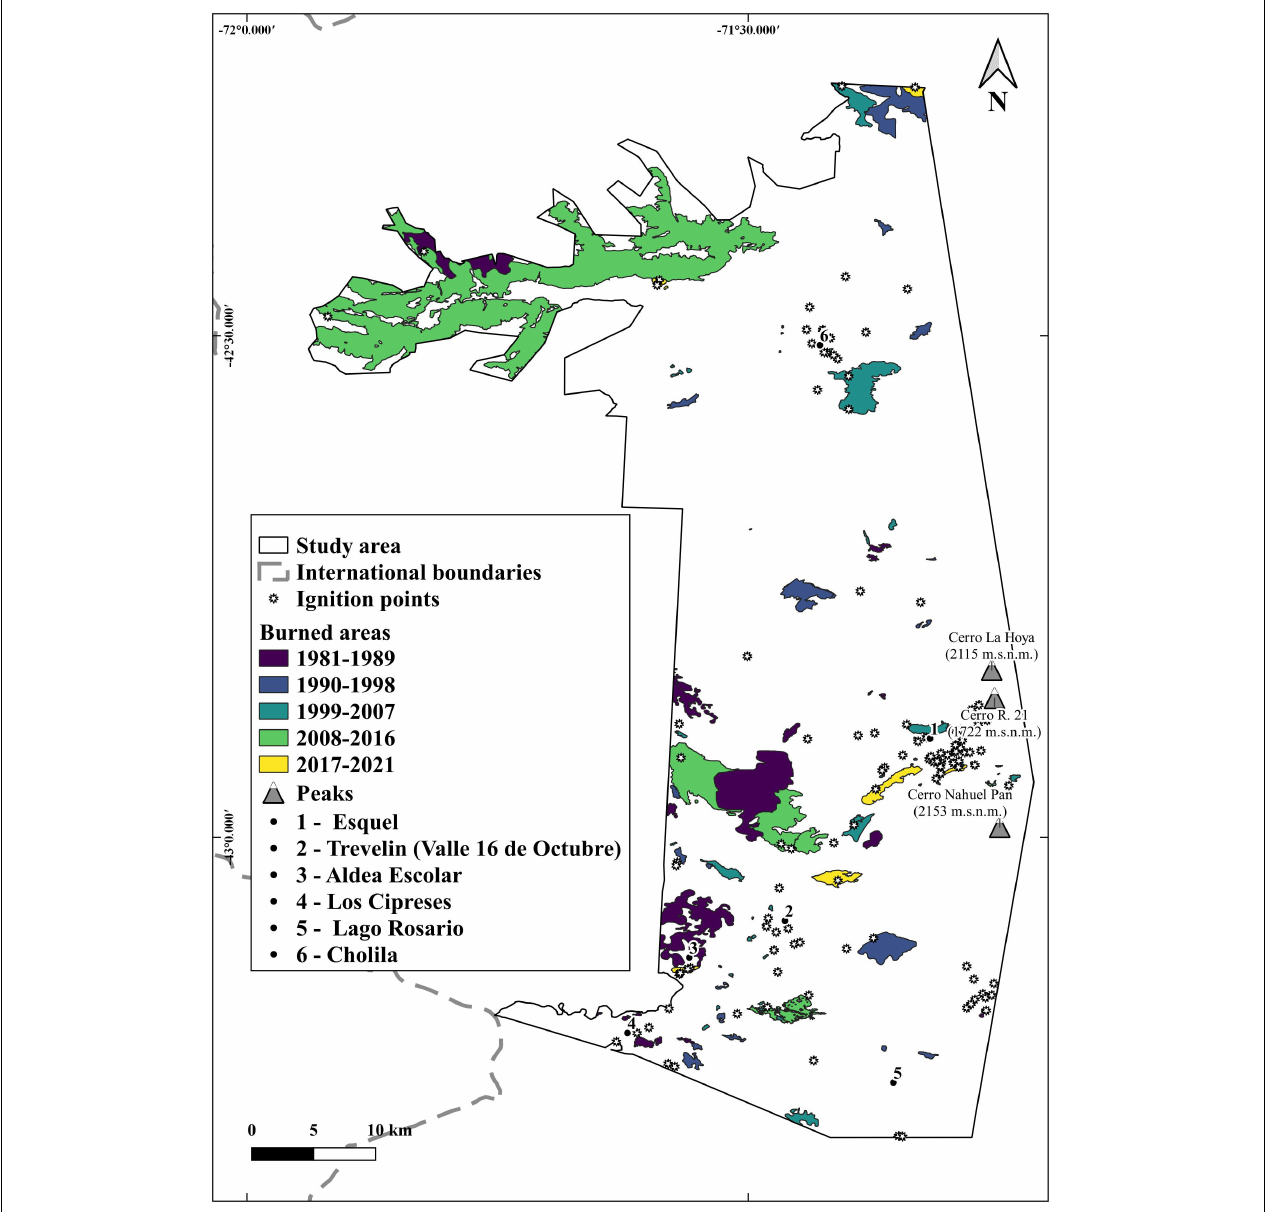
FIGURE 6 | Wildfires in the study area since 1982 and ignition points since 2000, both until 2021. Wildfires are grouped every 8 years, but the last group comprises 3 years.